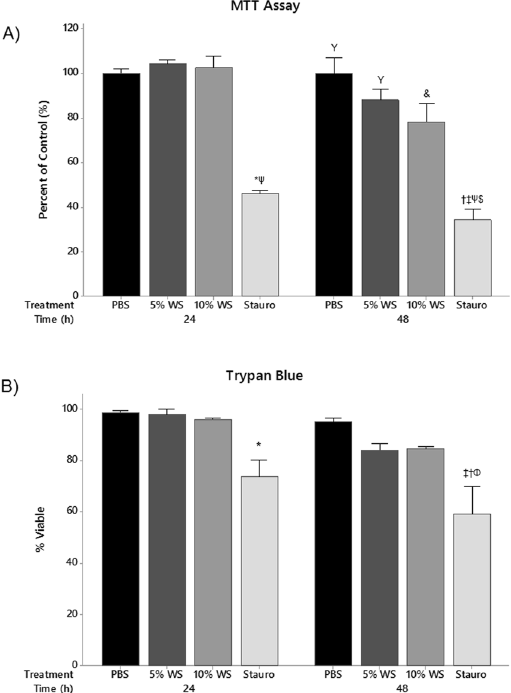
Figure 1. Wood Smoke and Cell Viability. ( A ) MTT and ( B ) trypan blue exclusion were used to assess the effects of WS on A549 cell viability. Staurosporine was used as a positive control for reduced viability. MTT * P < 0 . 001 vs. 24 h 5% WS, 10% WS; † P < 0 . 001 vs. 24 h 10% WS, ‡ P < 0 . 001 vs. 24 h 5% WS, Ψ P < 0 . 001 vs. 24 h PBS, & P < 0 . 01 vs. 24 h Stauro, Υ P < 0 . 001 vs. 24 h Stauro, $ P < 0 . 001 vs. 48 h PBS, 5% WS, 10% WS; n = 3). Trypan blue exclusion ( * P < 0 . 05 vs. 24 h Unt and 24 h 5% WS; † P < 0 . 001 vs. 24 h Unt; ‡ P < 0 . 001 vs. 24 h 5% and 10% WS and 48 h Unt; Φ P < 0 . 05 vs. 48 h 5% and 10% WS; n = 3). Statistical differences were